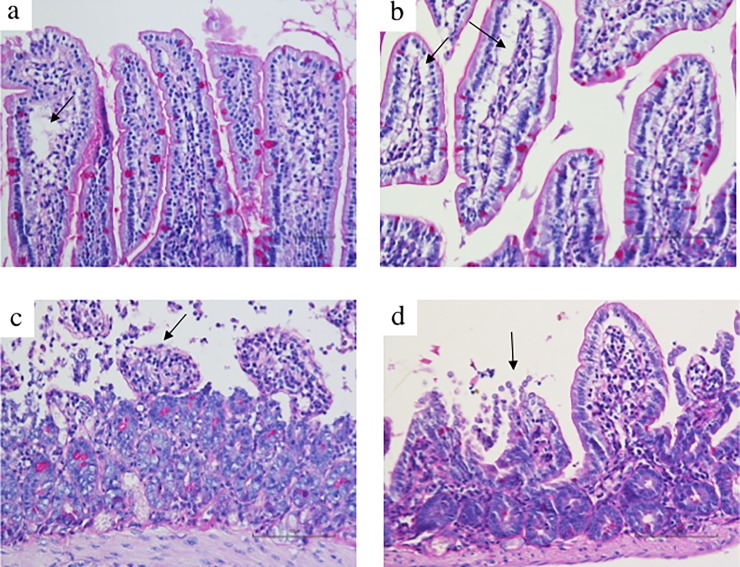
Intestinal histology.Representative micrographs of hematoxylin-eosin and PAS stained sections of jejunal-ileal specimens harvested from SO animals treated with vehicle (a) and B. bifidum PRL2010 (b) and from I/R mice pre-treated with vehicle (c) and B. bifidum PRL2010 (d) (scale bar: 100μm). Moderate expansion of Gruenhagen’s spaces (indicated by arrows in a and b) was visible both in vehicle- and in probiotic-treated SO mice. Mesenteric I/R caused extensive denudation of villi and, in some regions, digestion and disintegration of lamina propria (indicated by the arrow in c), with hemorrhages and ulceration; pre-treatment with B. bifidum PRL2010 was not able to prevent the I/R-induced mucosal lesions (indicated by the arrow in d).